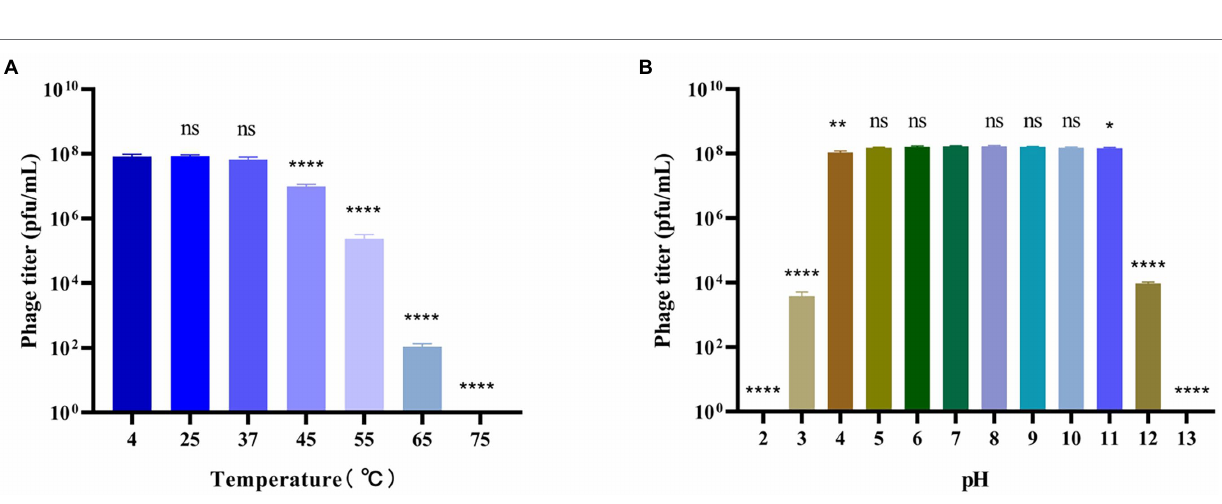
FIGURE 2 | Stability of bacteriophage BUCT603. (A) Thermal stability of the phage treated with different temperature for 12 h; (B) pH stability of the phage treated with different pH for 12 h. Data are shown as the mean ± SD, **** p < 0.0001, ** p < 0.01 and * p < 0.05 indicates a significant difference between this group and the